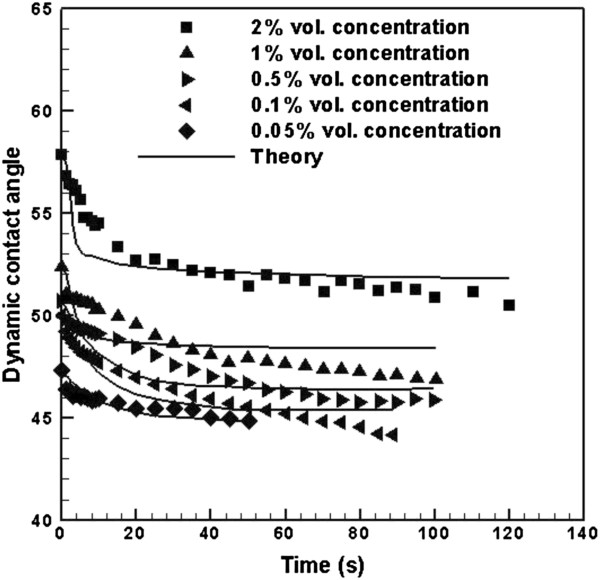
Dynamic contact angle of TiO2-DI water nanofluid, comparison of experiment and theory.